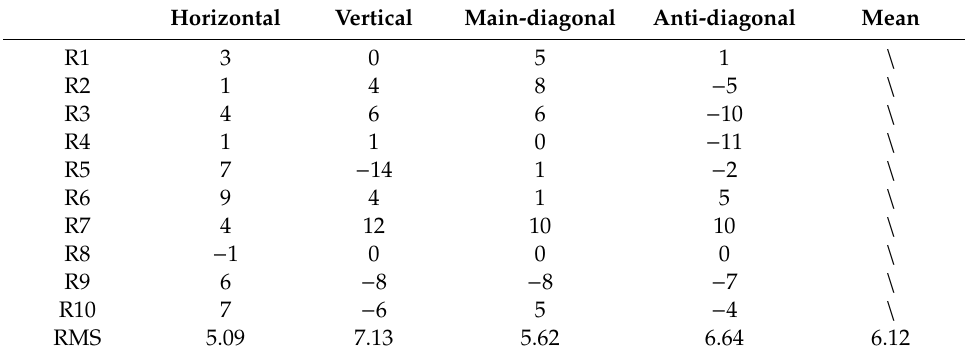
Table 4. Misalignment error in pixel number in four directions after calibration. Horizontal